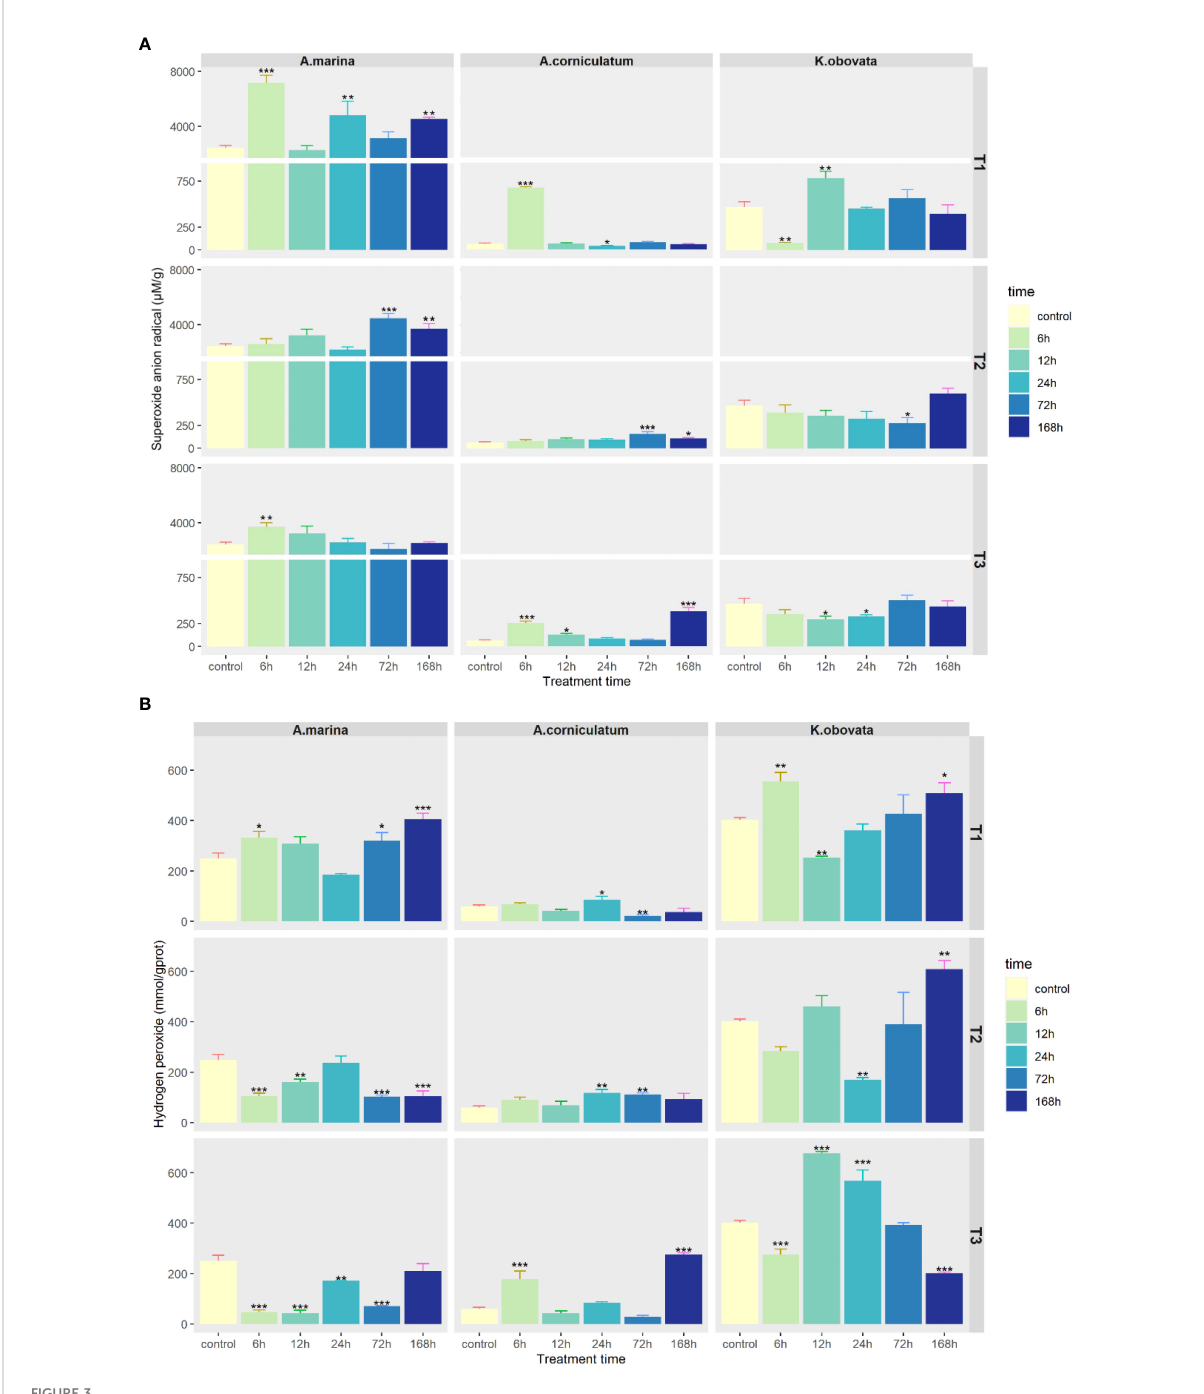
FIGURE 3 Changes of (A) Superoxide anion radical and (B) Hydrogen peroxide contents under upwelling stress. * indicates that there are signi fi cant differences between control and treatment groups [p<0.05(*), p<0.01(**), p<0.001(***)]. “ T1 ” means 5°C upwelling stress, “ T2 ” means 10°C upwelling stress and “ T3 ” means 15°C upwelling